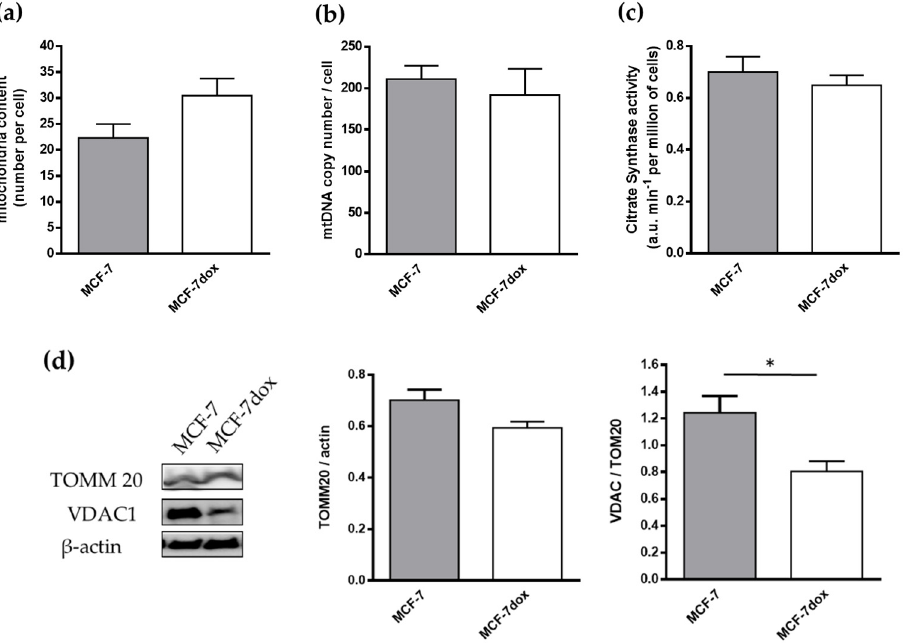
Figure 3. In the basal condition, there is no difference in mitophagy between the parental and the DOX-resistant breast cancer cell line. ( a ) Mitochondrial number was determined by transmission electron microscopy ( n = 4, 10 cells/n); ( b ) mitochondrial DNA copy number was determined by quantitative PCR ( n = 6); ( c ) maximal enzymatic activity of citrate synthase activity was measured by spectrophotometry ( n = 6); ( d ) the levels of TOMM20 and VDAC-1 were measured by western blotting with specific antibodies. Densitometric analysis results are presented as the ratio of TOMM20 and VDAC-1 level to actin level ( n = 5). The data are presented as mean ± SEM. * p < 0.05.